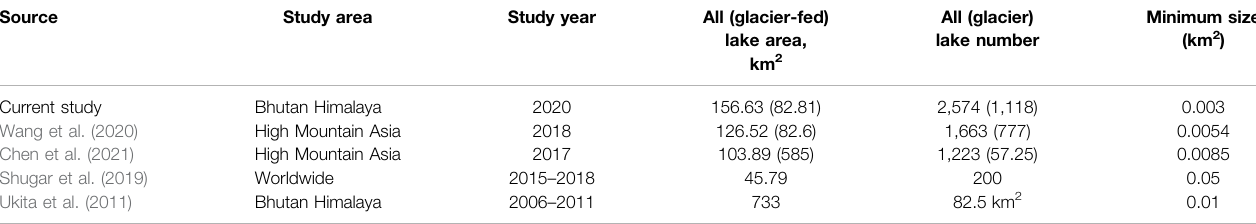
TABLE 5 | Comparison of the number and area of glacial lakes with the fi ndings of previous